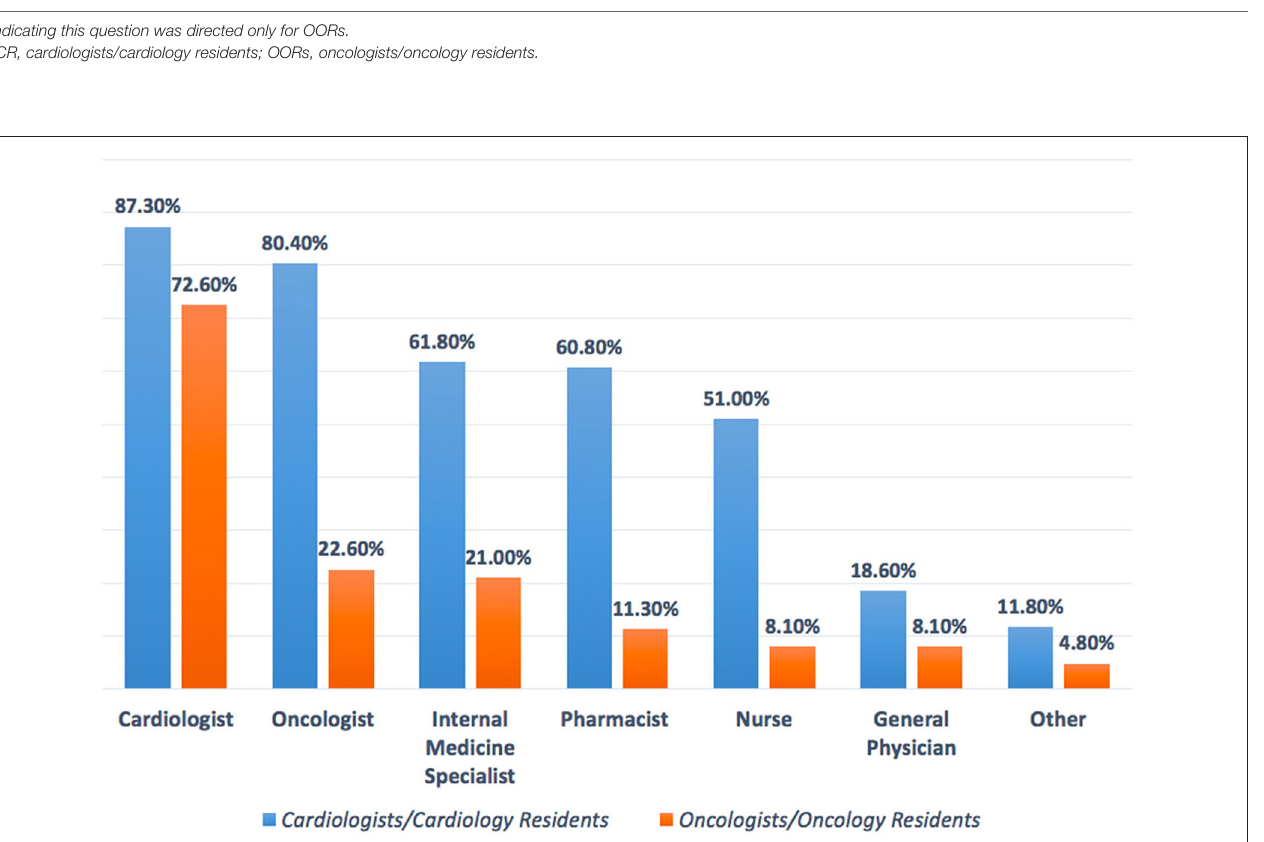
Frontiers in Cardiovascular Medicine |